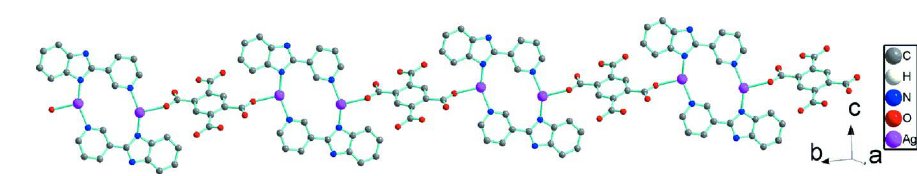
Figure 1 The structure of (I), with the atomic labels and 30% probability displacement ellipsoids for non-H atoms. [Symmetry codes: ( i ) 2 - x , - y , 2 - z ; ( ii ) 1 - x , 1 - y , 2 - z ].